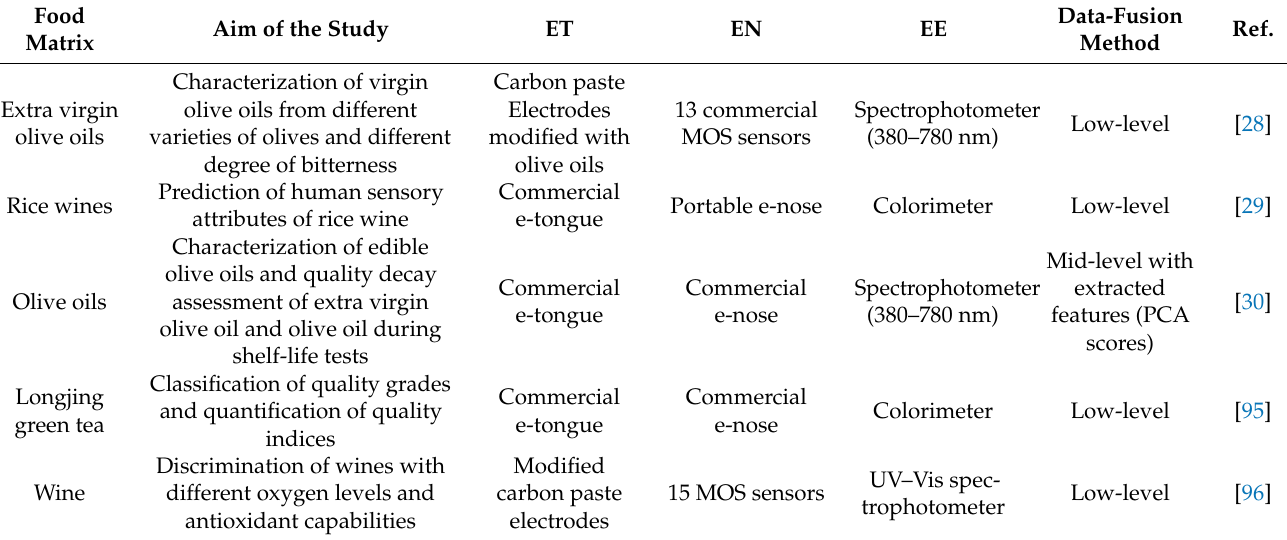
Table 5. List of publications related to the application of combined ET, EN, and